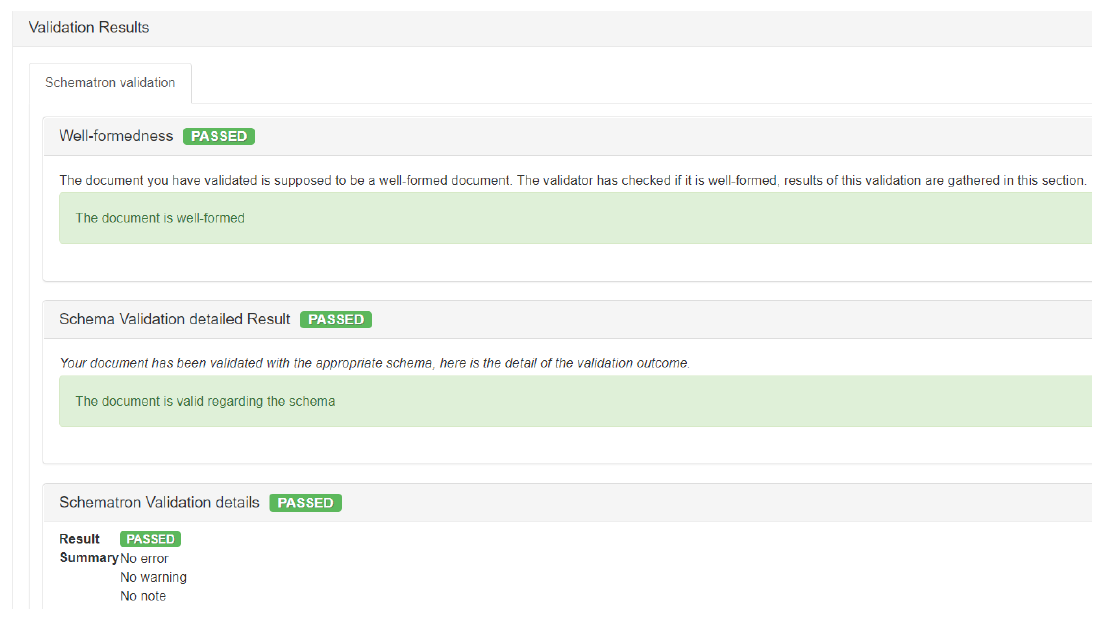
Figure 20. External validation service result showing conformity assessment for captured messages.